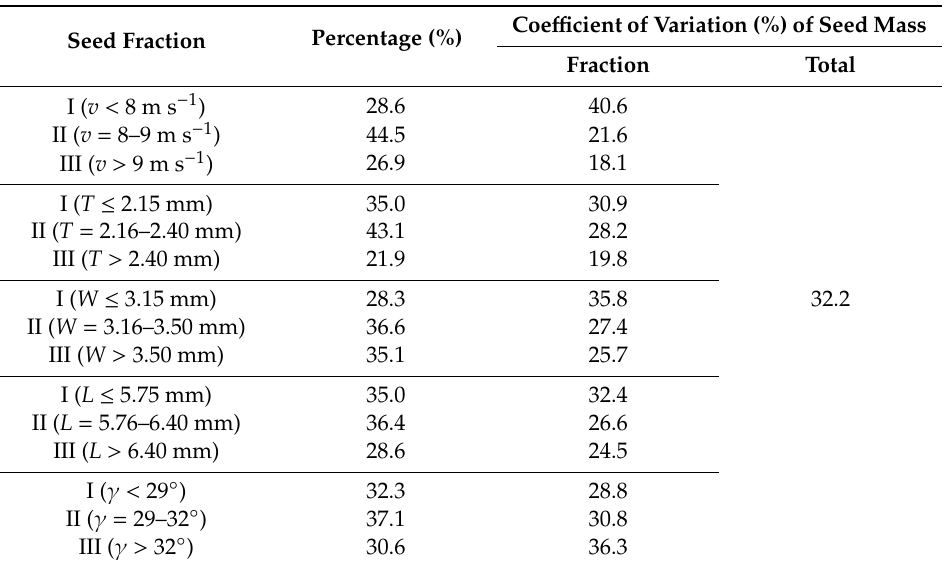
Table 3. Coe ffi cient of variation of seed mass in three seed